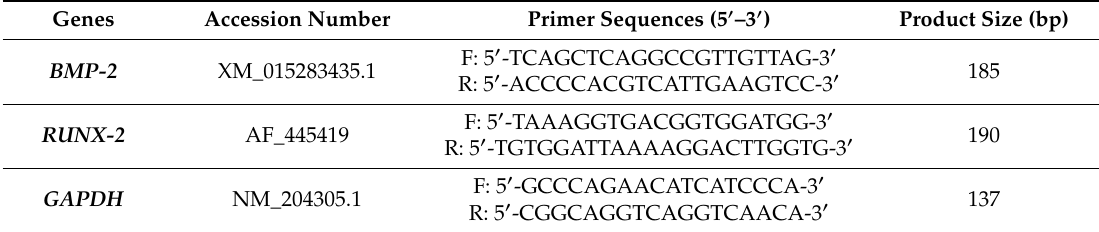
Table 1. Primers used in this